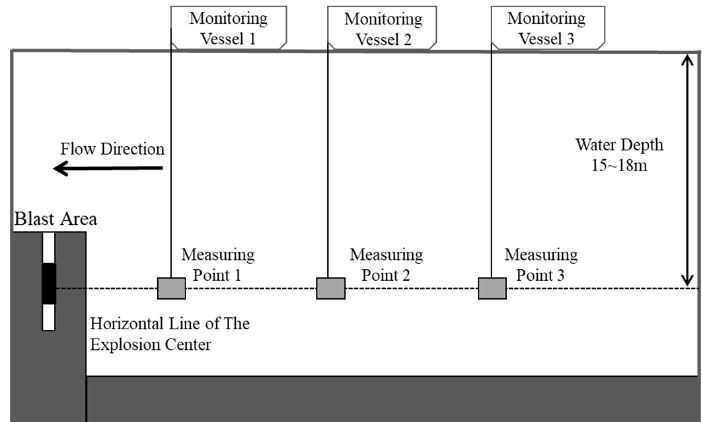
Figure 1. Diagram of the field monitoring.